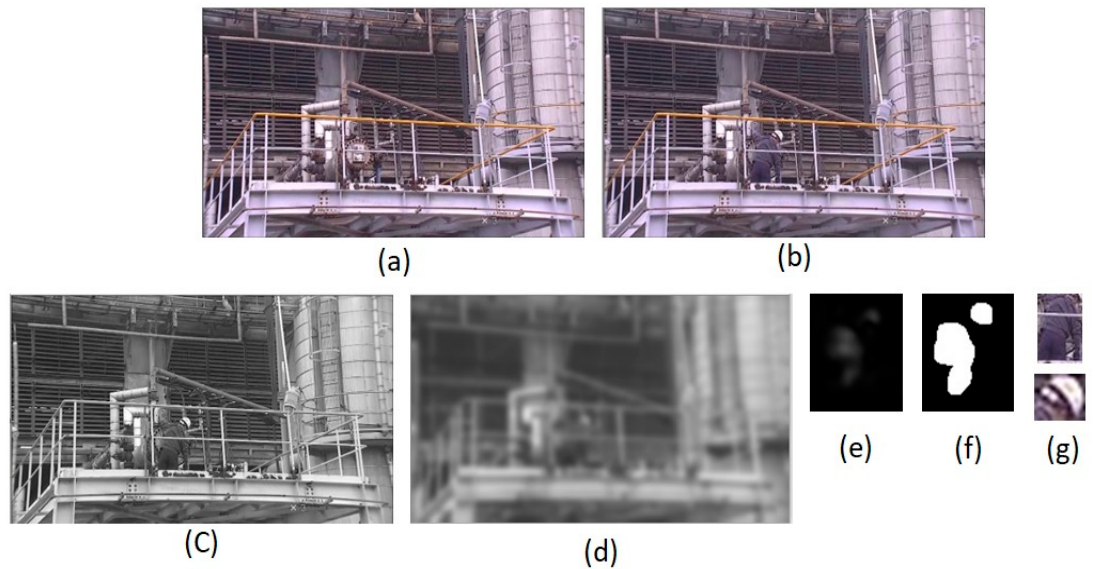
Figure 3. Obtaining images examples: ( a ) first background image; ( b ) current frame image; ( c ) grayscale image of ( b ); ( d ) Gaussian blur image of ( c ); ( e ) frame subtraction using cv2.absdiff image; ( f ) threshold image of ( e ); and ( g ) result image achieved from ( f ).